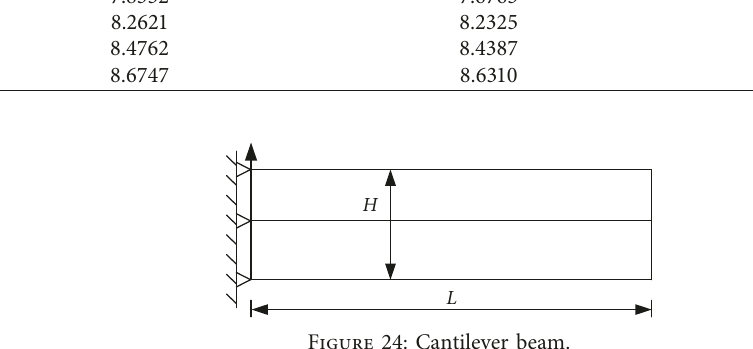
Figure 24: Cantilever beam.